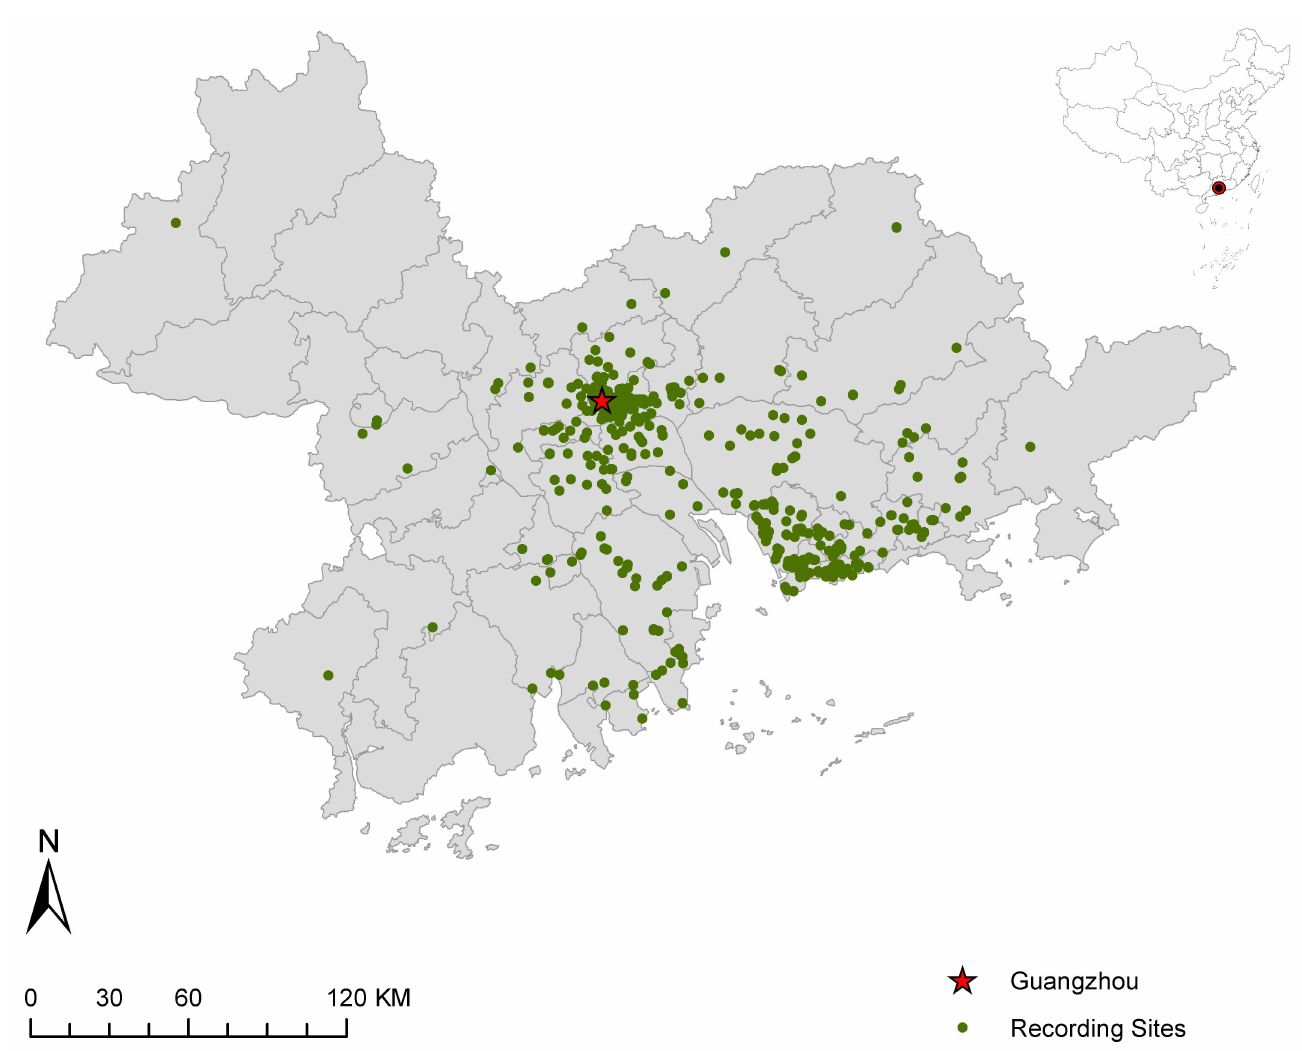
Figure 1. Distribution of recording